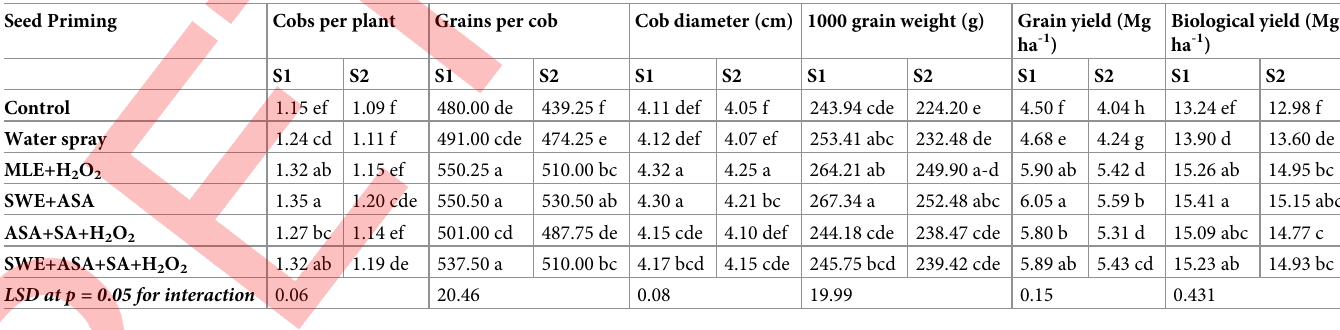
Table 2. Yield and related attributes of maize influenced by foliar applied growth promoting agents and sowing dates. Seed Priming Cobs per